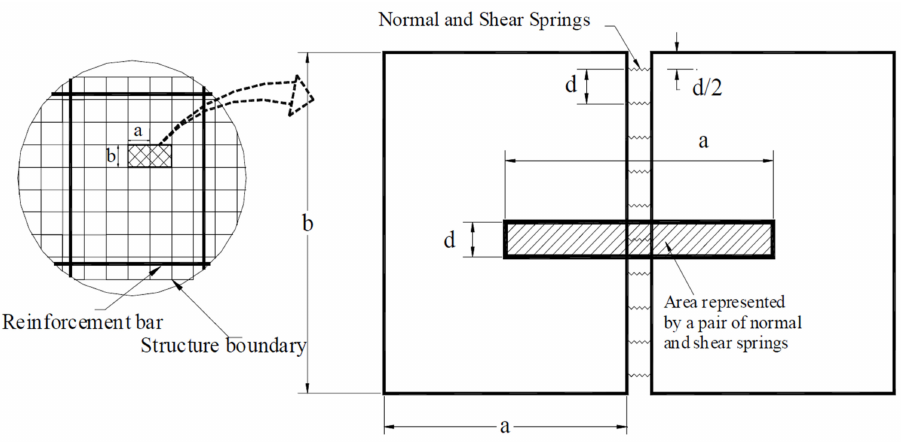
Figure 3. AEM structural discretization for structural